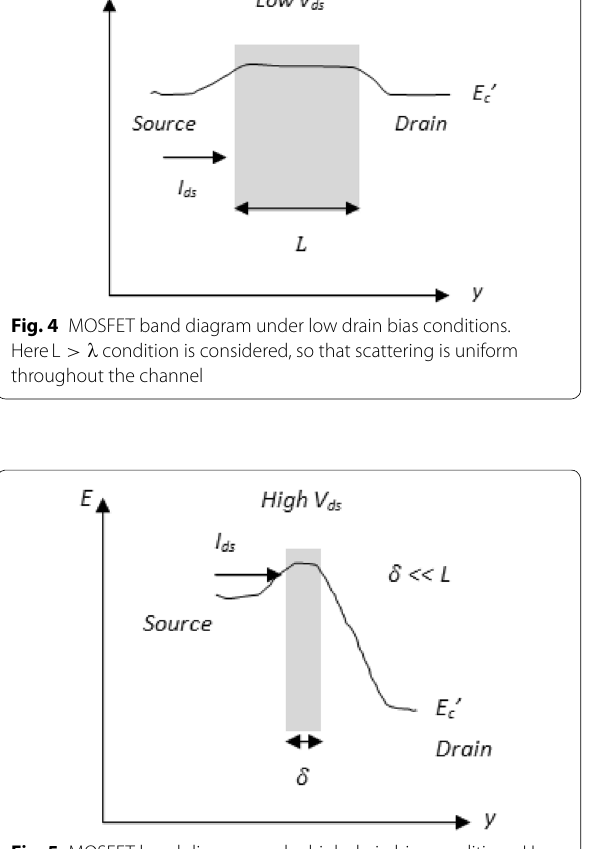
Fig. 5 MOSFET band diagram under high drain bias conditions. Here δ L condition is considered. Carrier scattering depends on the ≪ critical layer width δ , near the low field source